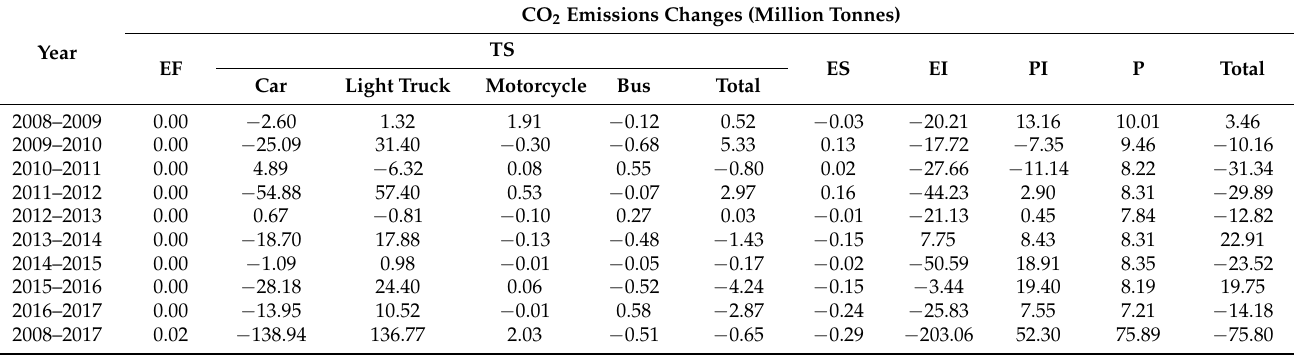
Table 3. Results for the decomposition of the U.S. road passenger transport